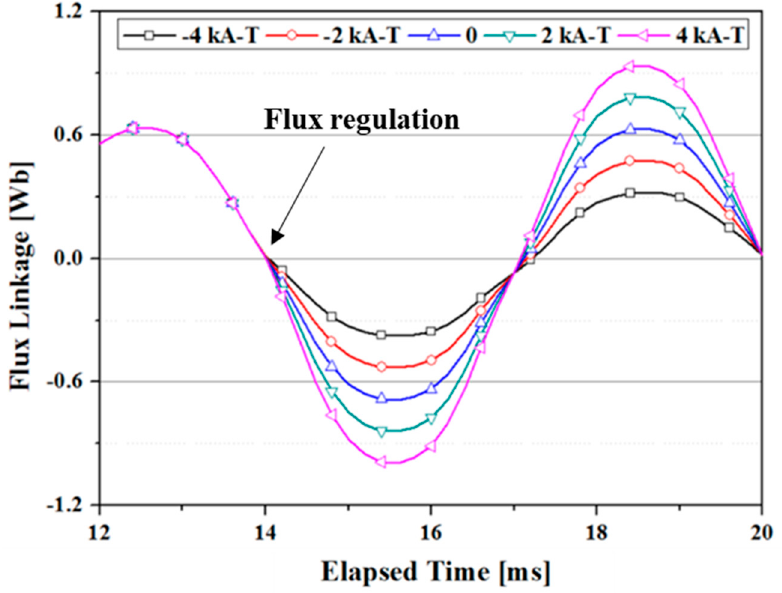
Figure 18. Flux linkage of Phase C according to the MMF of the additional field winding.